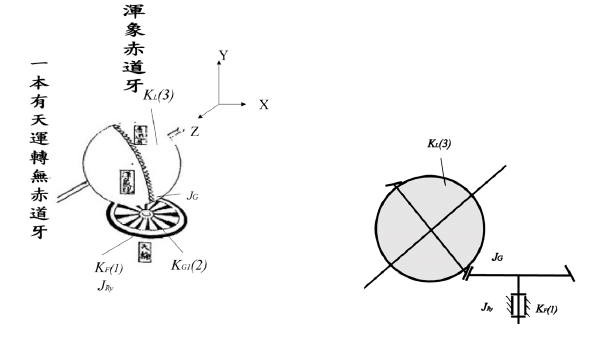
Figure 4. Su Song’s celestial globe transmission system (Hu,